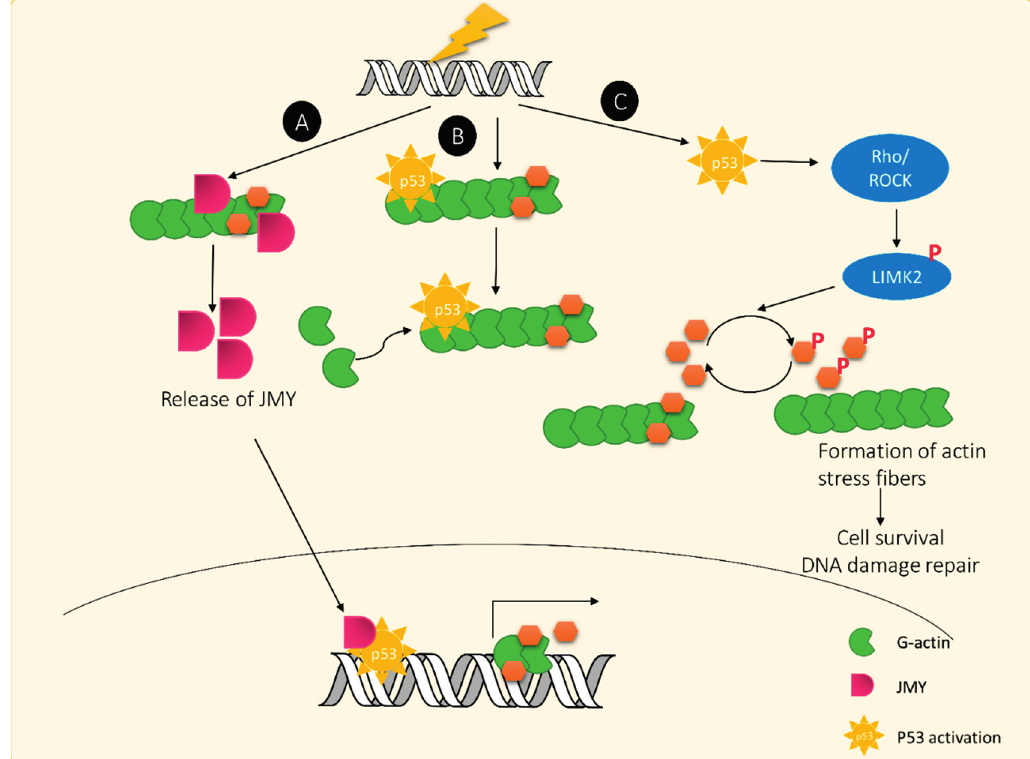
Figure 4. Regulatory mechanisms of actin dynamics in response to DNA